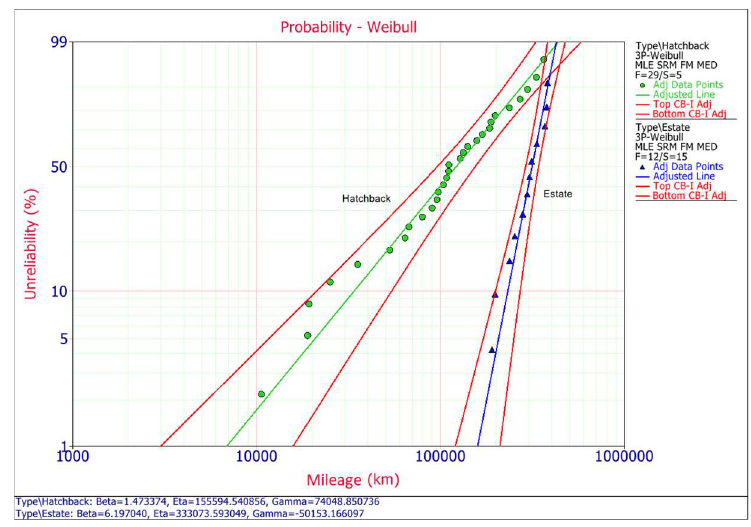
Figure 3. Comparison of 3P-Weibull probability.